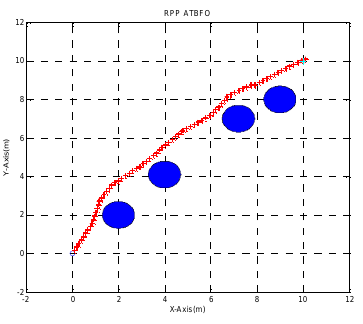
Fig. 6. Best shortest path (2 nd scenario) for case 1.